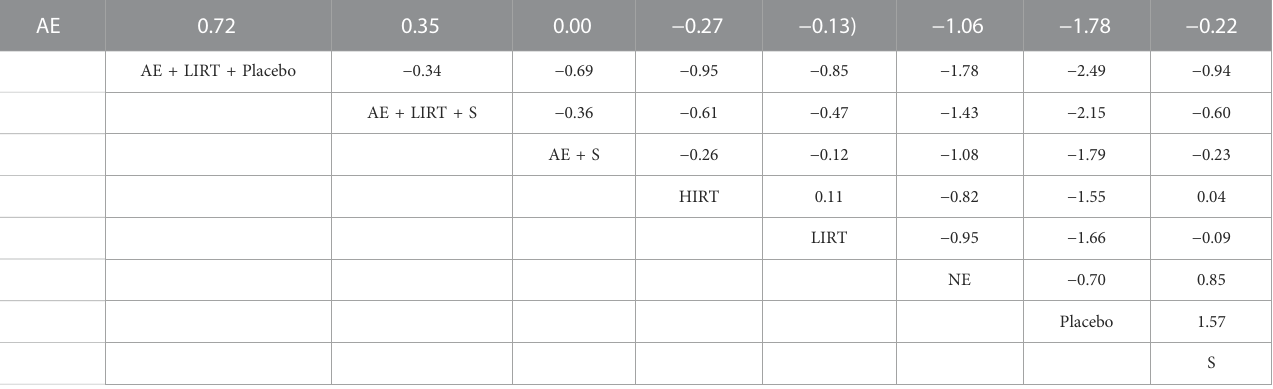
TABLE 3 The league tables of the network geometries.